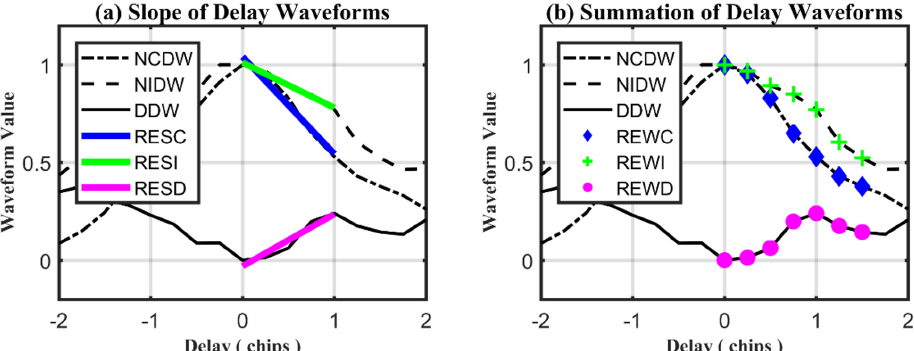
Figure 6. ( a ) GNSS-R Features demonstration of RESC (Right Edge Slope of CDW), RESI (Right Edge Slope of IDW), and RESD (Right Edge Slope of DDW). The fitting slope of blue, green, and magenta lines are defined as RESC, RESI, and RESD, respectively. ( b ) GNSS-R Features demonstration of REWC (Right Edge Waveform Summation of CDW), REWI (Right Edge Waveform Summation of IDW), and REWD (Right Edge Waveform Summation of DDW). The waveform summation of the blue, green, and magenta dots are defined as REWC, REWI, and REWD,